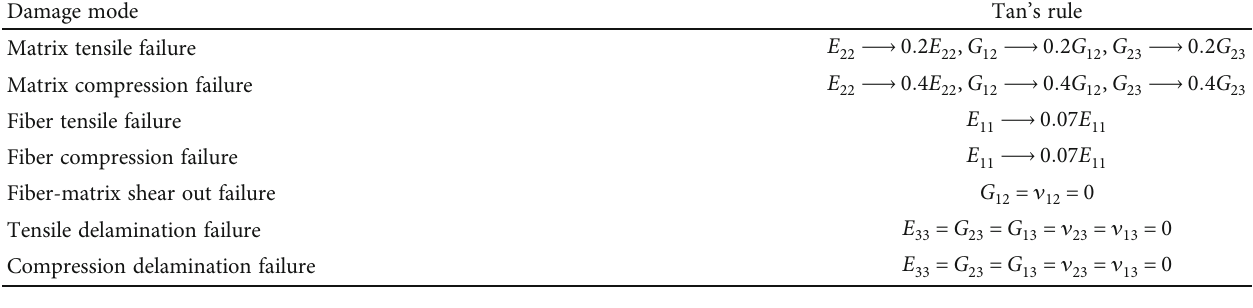
Table 2: Tan ’ s material degradation model.